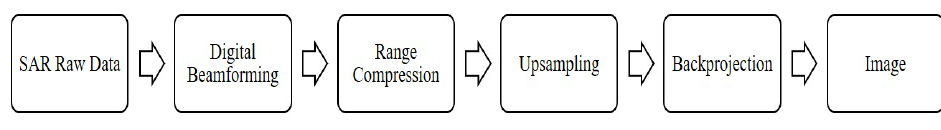
Figure 4. Image formation diagram for the